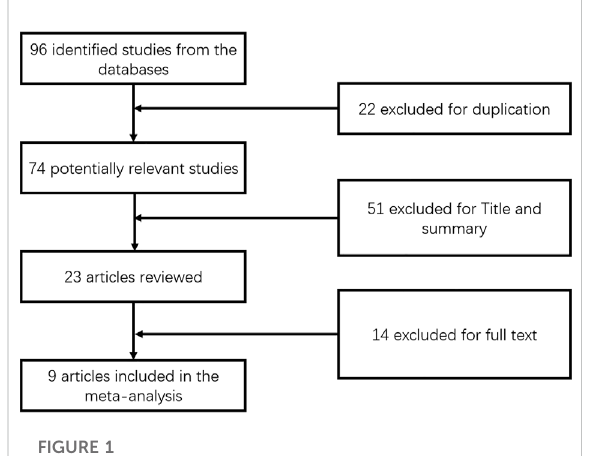
FIGURE 1 Flow diagram of the studies included in the